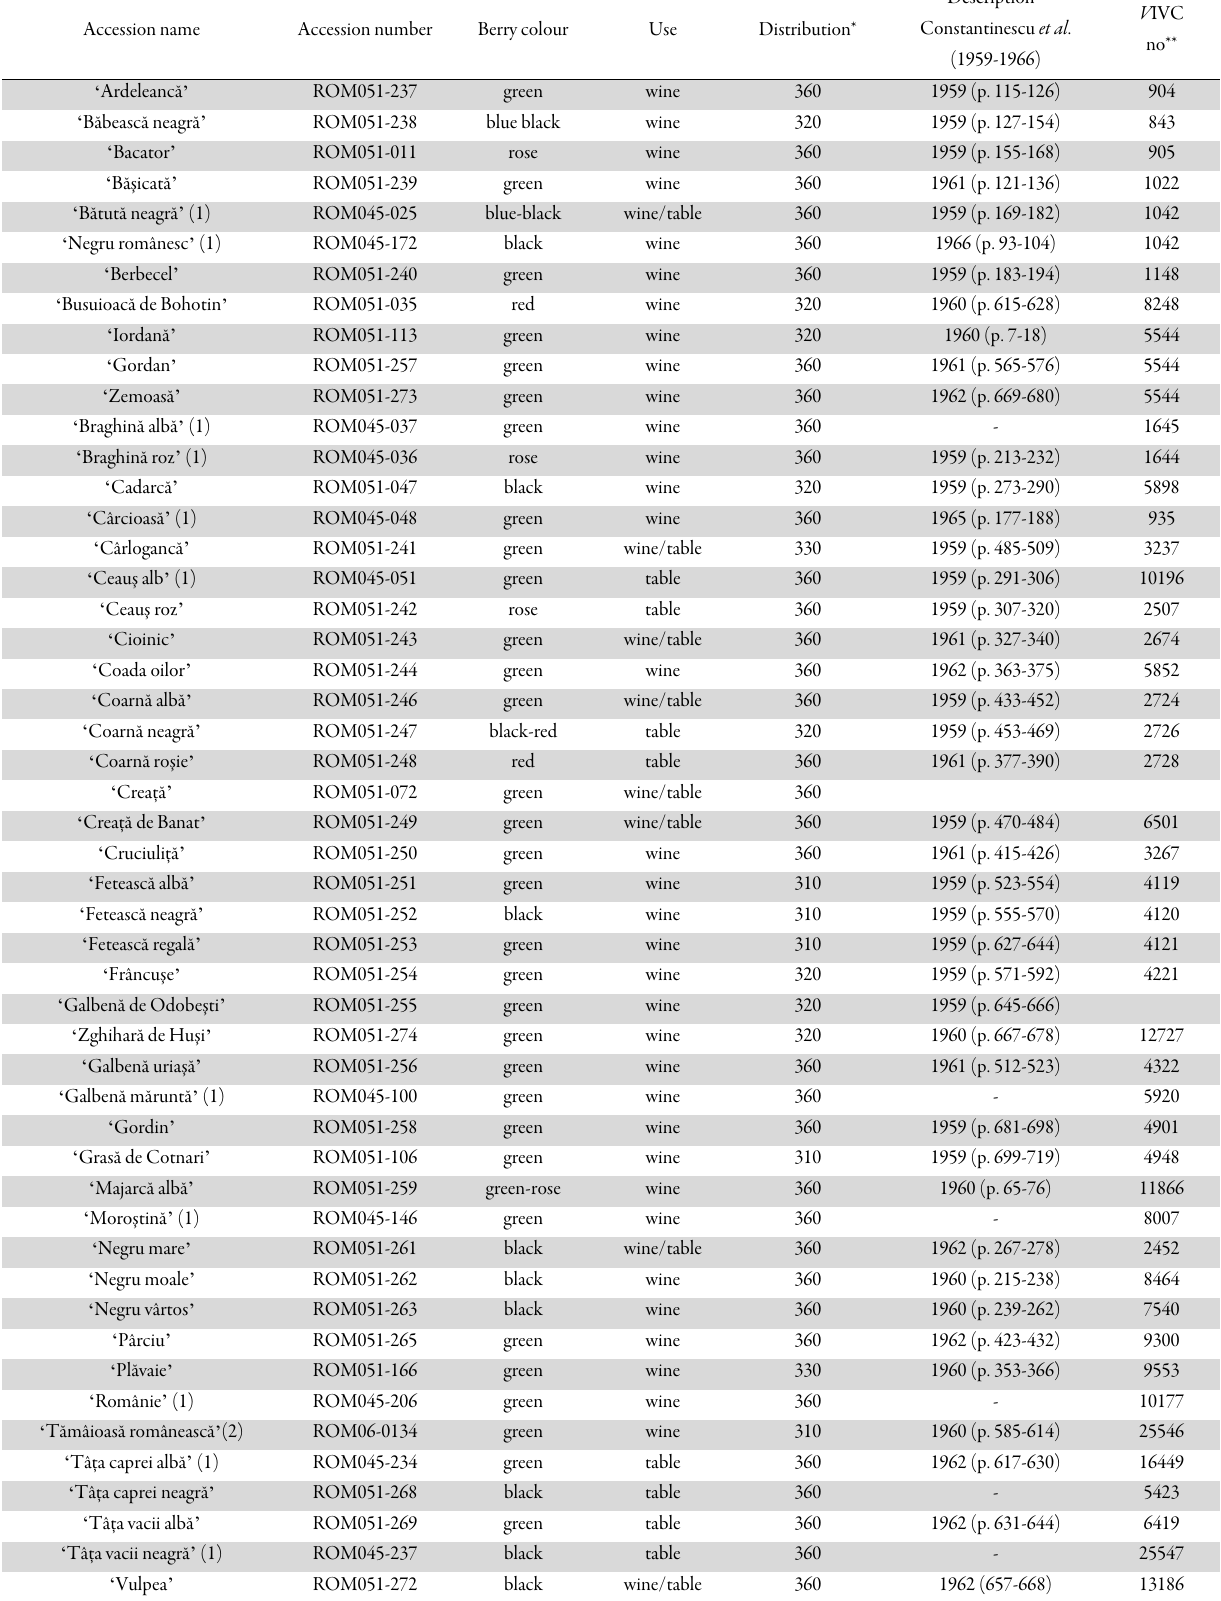
Table 1. Grapevine cultivars characterized using OIV descriptors and SSR